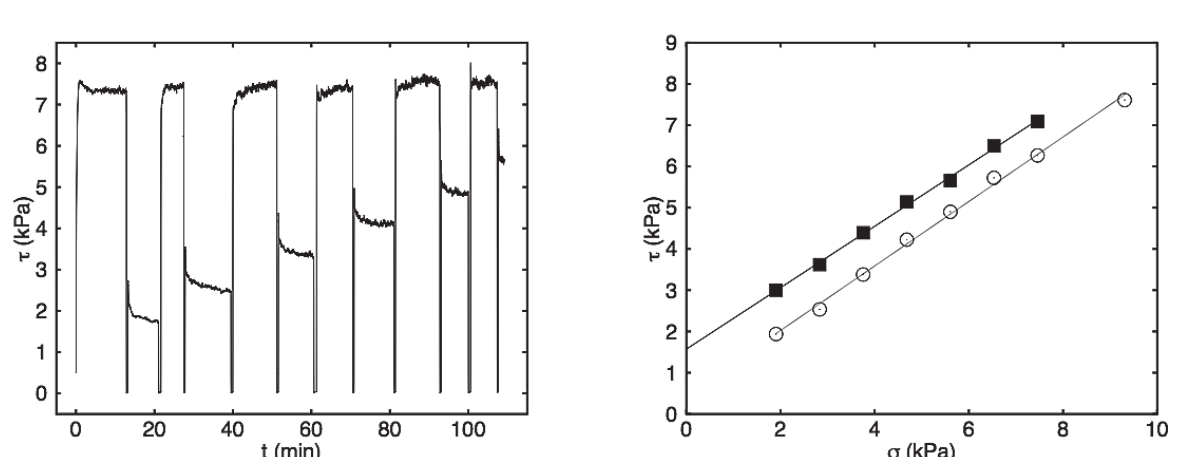
Fig. 2 Shear test (left) and corresponding yield (squares) and dynamic (circles) locii for the 50-125 µm sieved calcite with a liquid to solid ratio of 0.5. The consolidation normal stress here is σ